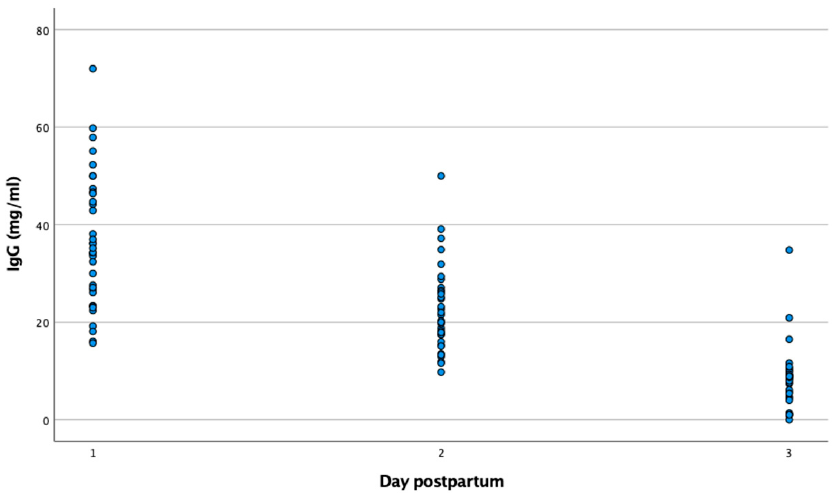
Figure 1. Distribution of IgG concentrations in goat colostrum samples obtained over the first three days after parturition, as measured by ELISA.